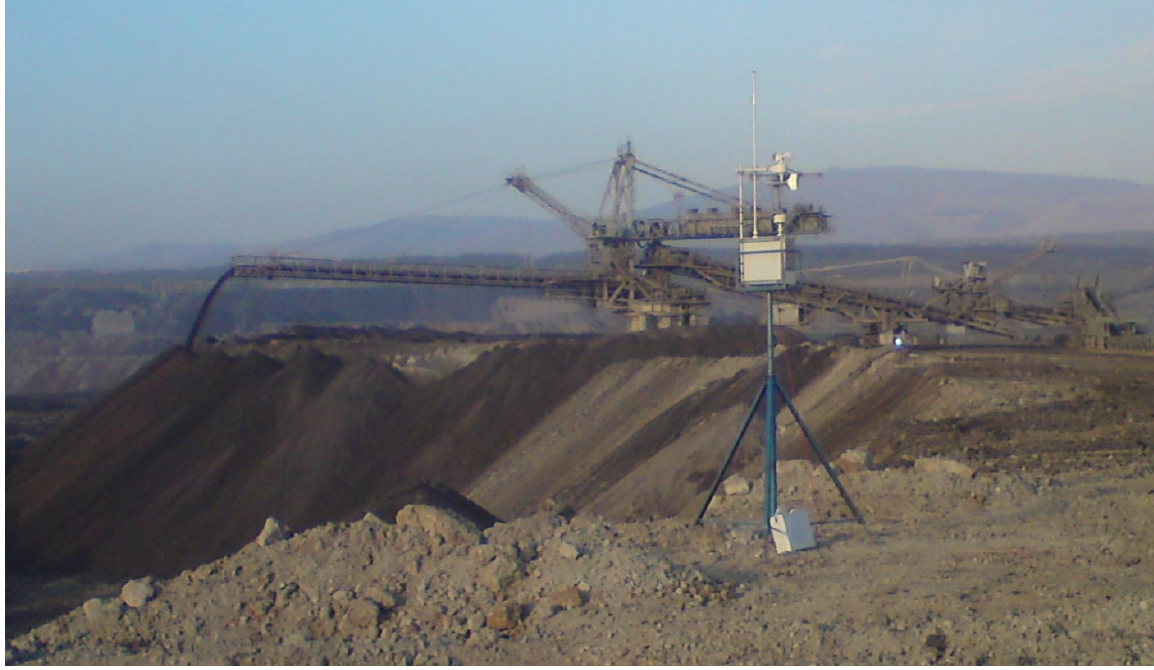
Figure 2. Stacker in the mine of Kardia field during one of the measurements campaign. One of the installed PMx monitors is also shown.